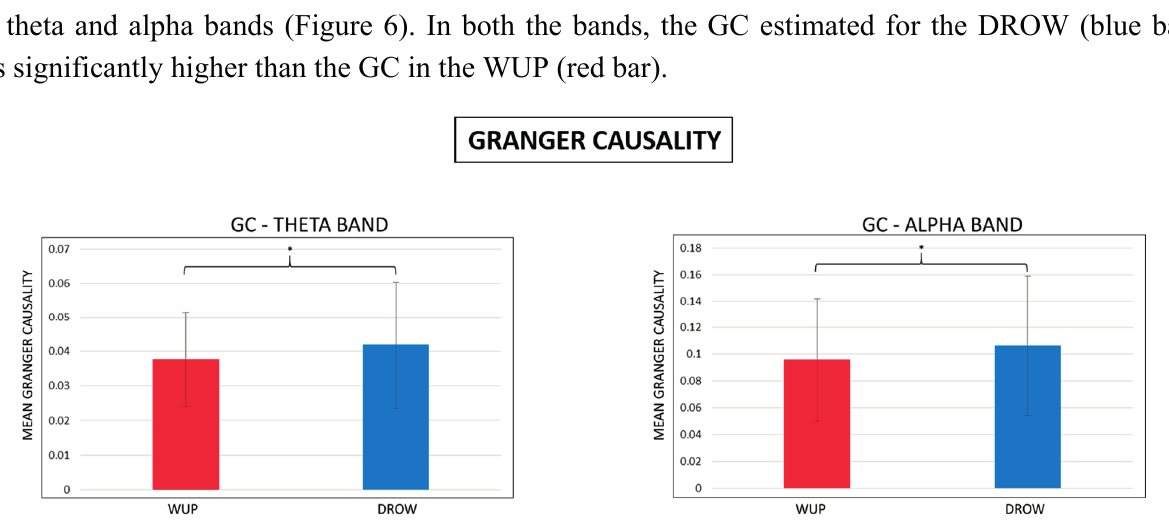
Figure 6. Mean Granger Causality (GC) in the theta and alpha bands. Note that the GC estimated for the DROWSY condition was significantly ( p < 0.05) higher than the GC in